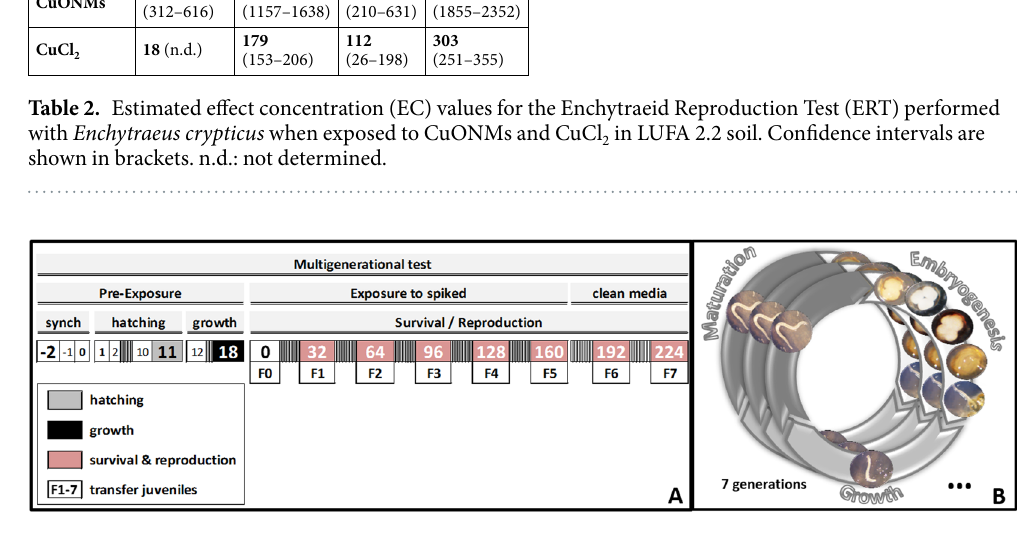
Figure 2. Schematic representation of Enchytraeus crypticus multigenerational test. The figure includes ( A ) Multigenerational test design including sampling days for synchronization and transfer between generations and ( B ) life stages from cocoon to mature adults and the following generations and associated time